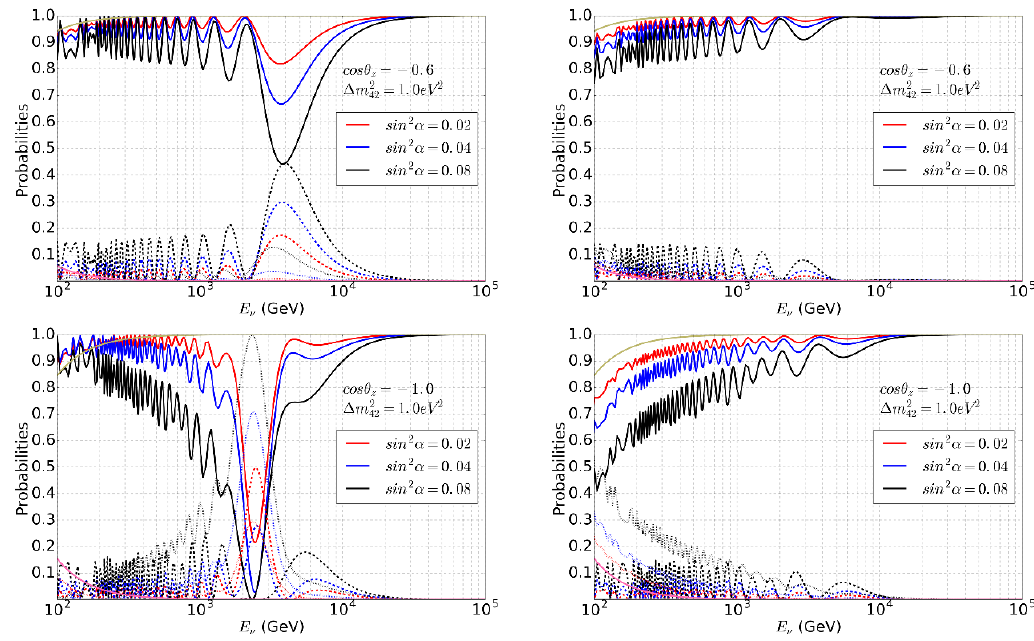
Figure 1 . Mass mixing scheme probabilities for (cid:22) (cid:23) (cid:22) (left panels) and (cid:23) (cid:22) (right panels) for a mantle crossing trajectory (top panels) and a mantle-core-mantle crossing trajectory (bottom panels). The continuous lines correspond to P (cid:22)(cid:22) , dashed lines to P (cid:22)s and dotted lines to P (cid:22)(cid:28) . The green and pink lines (unlabelled) correspond to P (cid:22)(cid:22) and P (cid:22)(cid:28) with no sterile neutrino